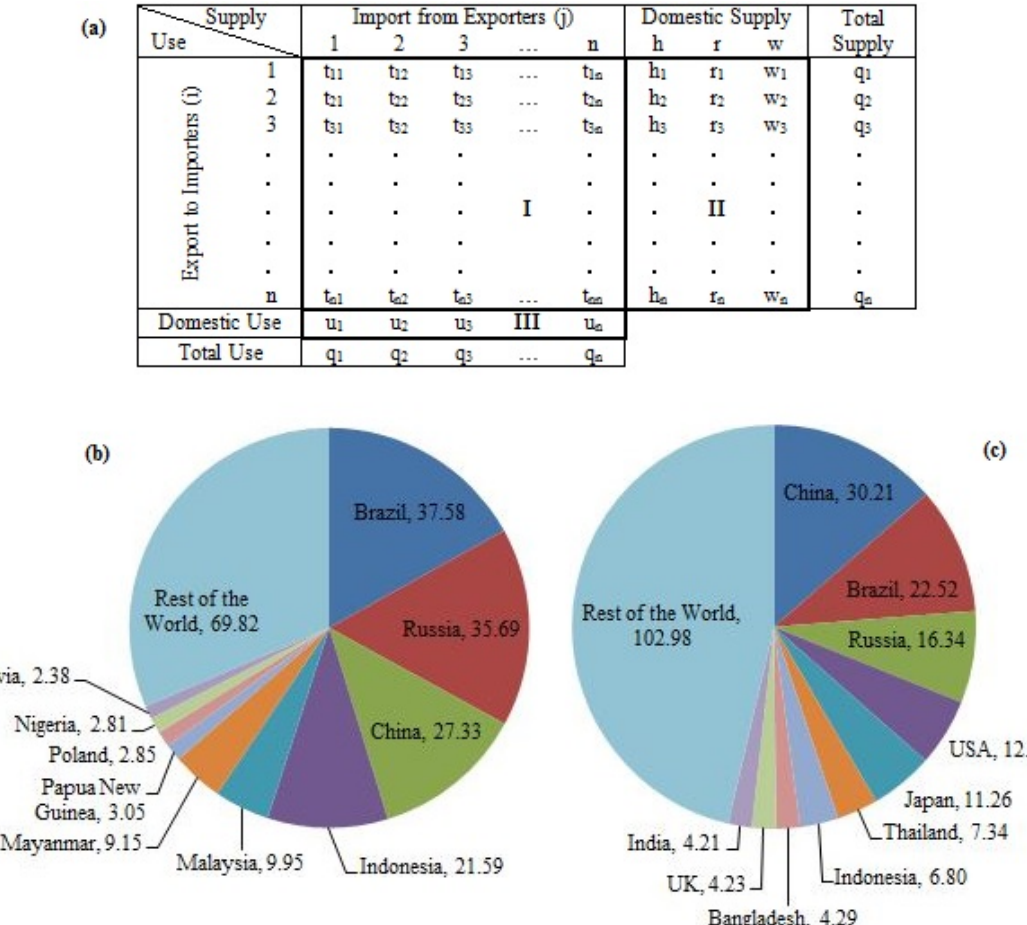
Figure 1. ( a ) Global production, trade, and consumption of timber and wood products illustrated in an input–output table, reprinted from Dieter [17]. t is bilateral trade, h is domestic harvested wood, r is domestic recovered paper, w is domestic waste wood, u is domestic use, and q is total use (supply); ( b ) Production of illegal timber in the top 10 producing countries; ( c ) Consumption of illegal timber in the top 10 consuming countries. Note: all data are in the unit of m 3 raw wood equivalent; the data source of ( b , c ) is Dieter [17]; except for China, all the data is based on high estimation.